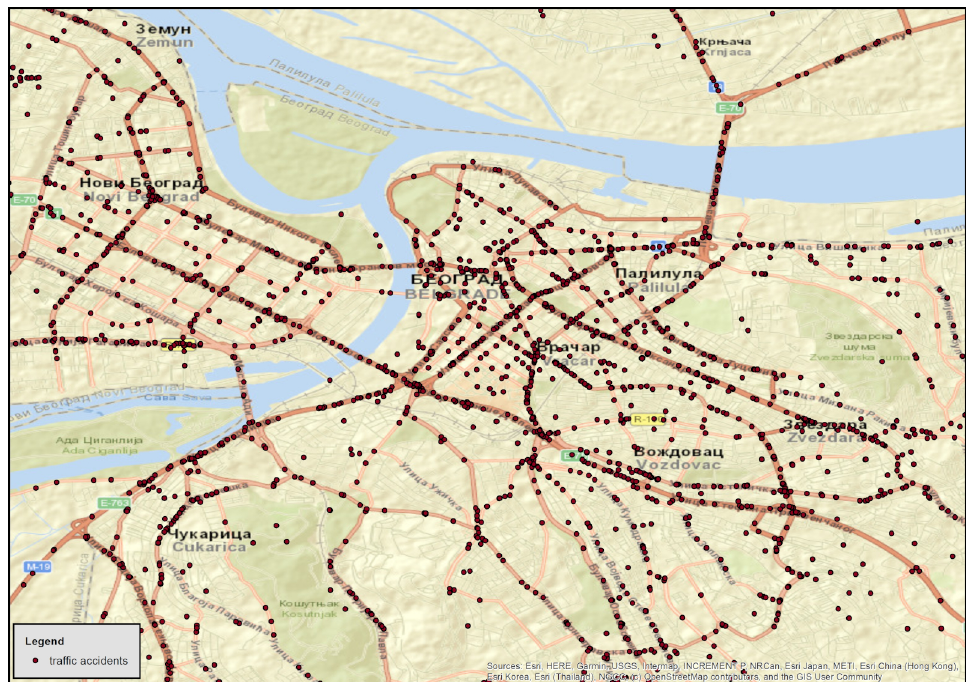
Figure 1. The map of road traffic accidents with injuries or death that occurred in “inner” Belgrade over the one-year period from January 2021 to December 2021. The map was generated using the ArcMap component of the Esri’s ArcGIS suite